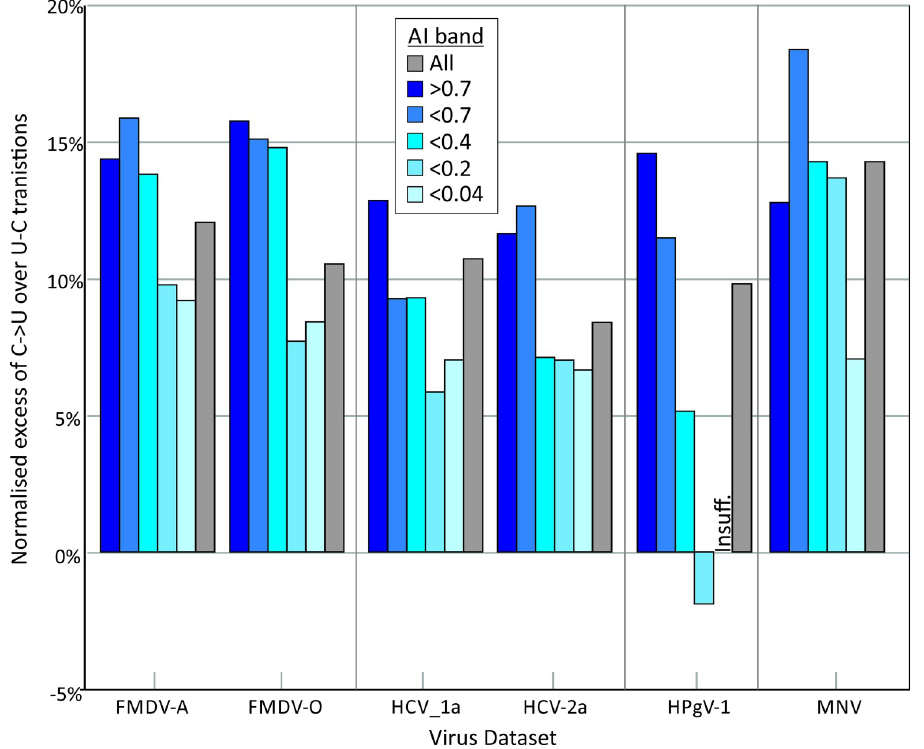
Fig 9. Proportionate excess of C- > U over U- > C transitions in phylogenetically informative and non-informative sites. Excess C- > U mutations (number of sites with majority C- > U transition–sites with U- > C) expressed as a proportion of all variable sites in genome alignments of viruses showing C- > /U- > C asymmetry. Proportions were normalised by mononucleotide base frequencies. Separate proportions were calculated by AI band, representing sites that were phylogenetic informative (low AI values) through to uninformative (high AI